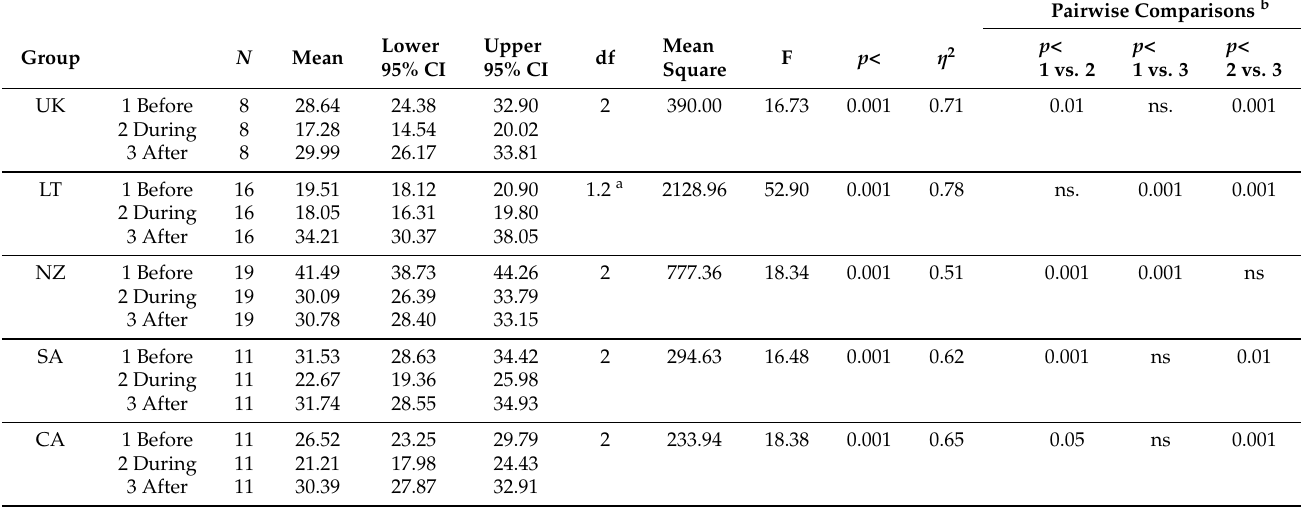
Table 10. The results of a repeated measures (within-subjects) ANOVA test assessing differences in the pairwise heart rhythm synchronization for all five groups during 15-min periods before (1), during (2) and after (3) using the Heart lock-In technique ( a —Mauchly’s Test of Sphericity was violated, Greenhouse-Geisser df correction applied; b —Adjustment for multiple comparisons: Bonferroni). Note that in order to assess the pairwise heart rhythm synchronization between participants in one group, the Euclidean distance from the optimal time lag vectors of each participant to all other participants in the group was computed and mean Euclidean distance was calculated. The lower mean Euclidean distances correspond to the higher level of pairwise synchronization. It can be seen, for example, that the California’s group members’ heart rhythms were significantly more synchronized with each other during the HLI period than before and after the HLI period, etc.